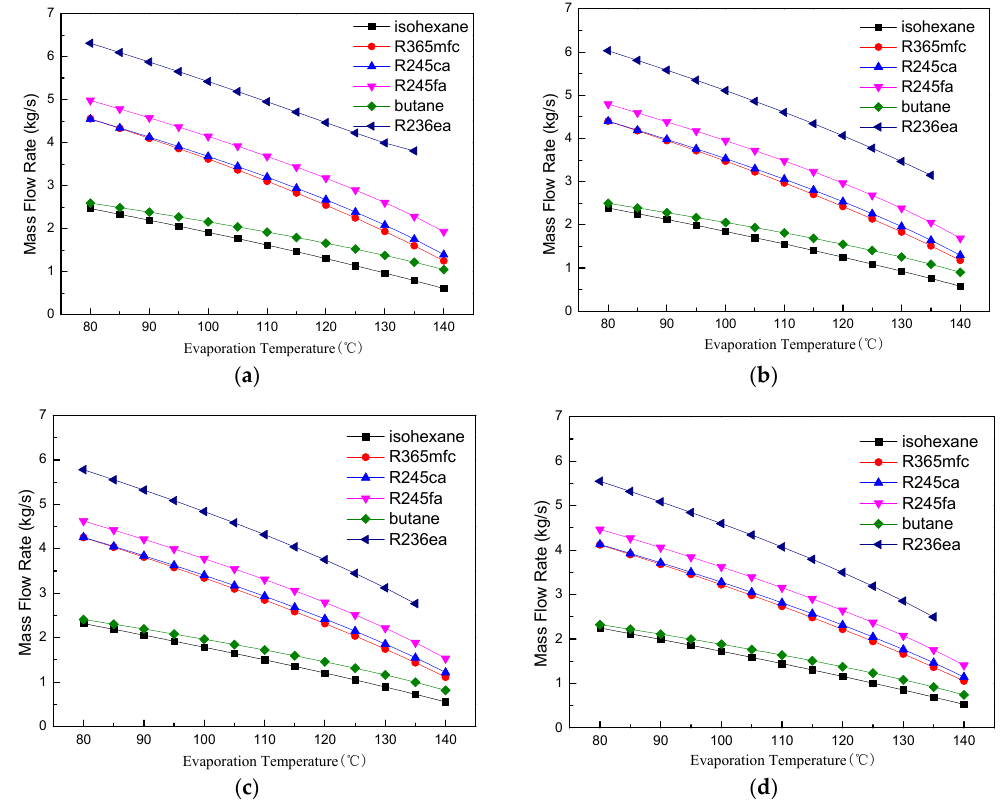
Figure 5. Variations of mass flow rate with evaporation temperature at four different degrees of superheat: ( a ) 0 °C degree of superheat; ( b ) 5 °C degree of superheat; ( c ) 10 °C degree of superheat; and ( d ) 15 °C degree of superheat.